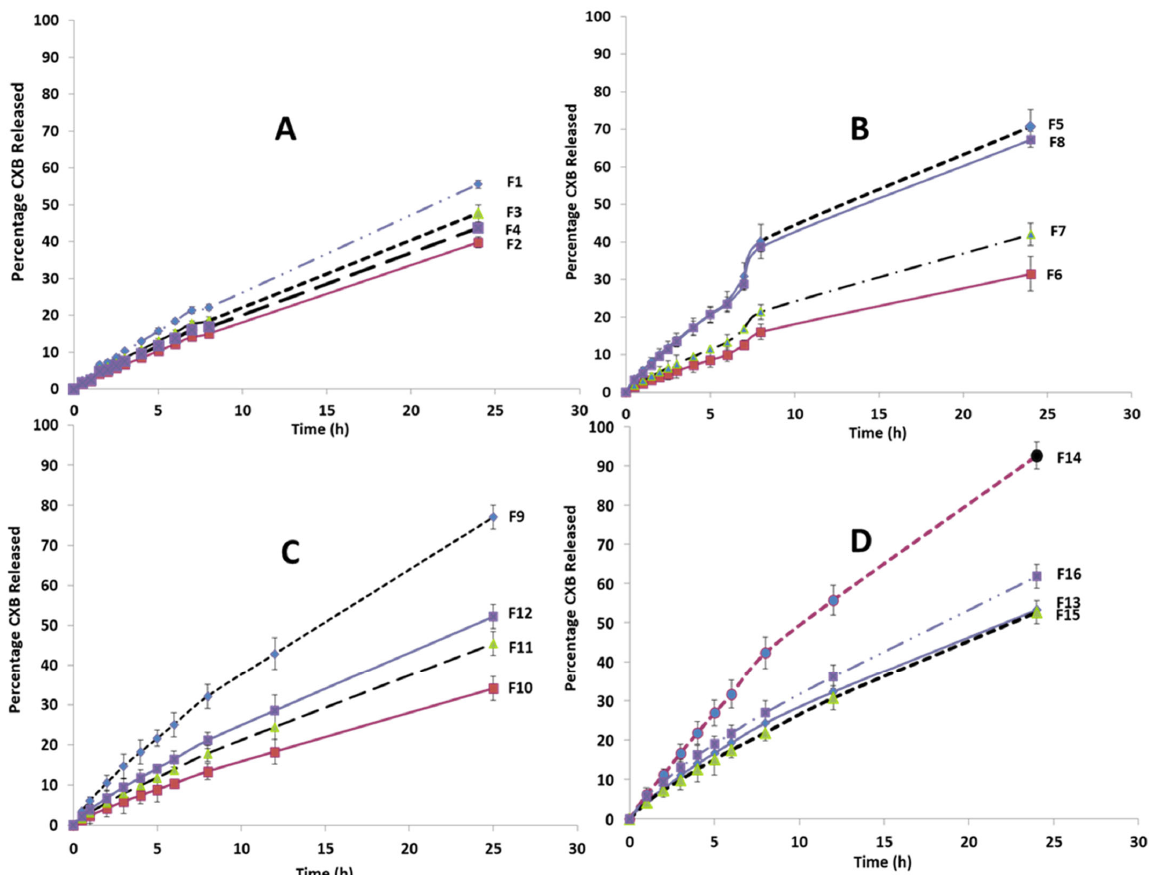
Figure 5. Release profile of CXB from all SLN formulation: ( A ) Effect of the type of lipid; ( B ) Effect of doubling the ratio of the surfactant (Tween 80); ( C ) Effect of using combination of lipids; ( D ) Effect of using Cremophor EL as a surfactant. NB: All of the lines were drawn by connecting all graph points to form the observed release profile shape, rather than by fitting to the data points.